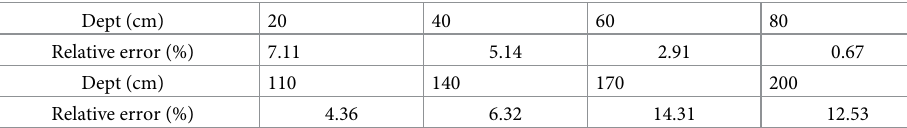
Table 3. Relative error of measured temperature values for water